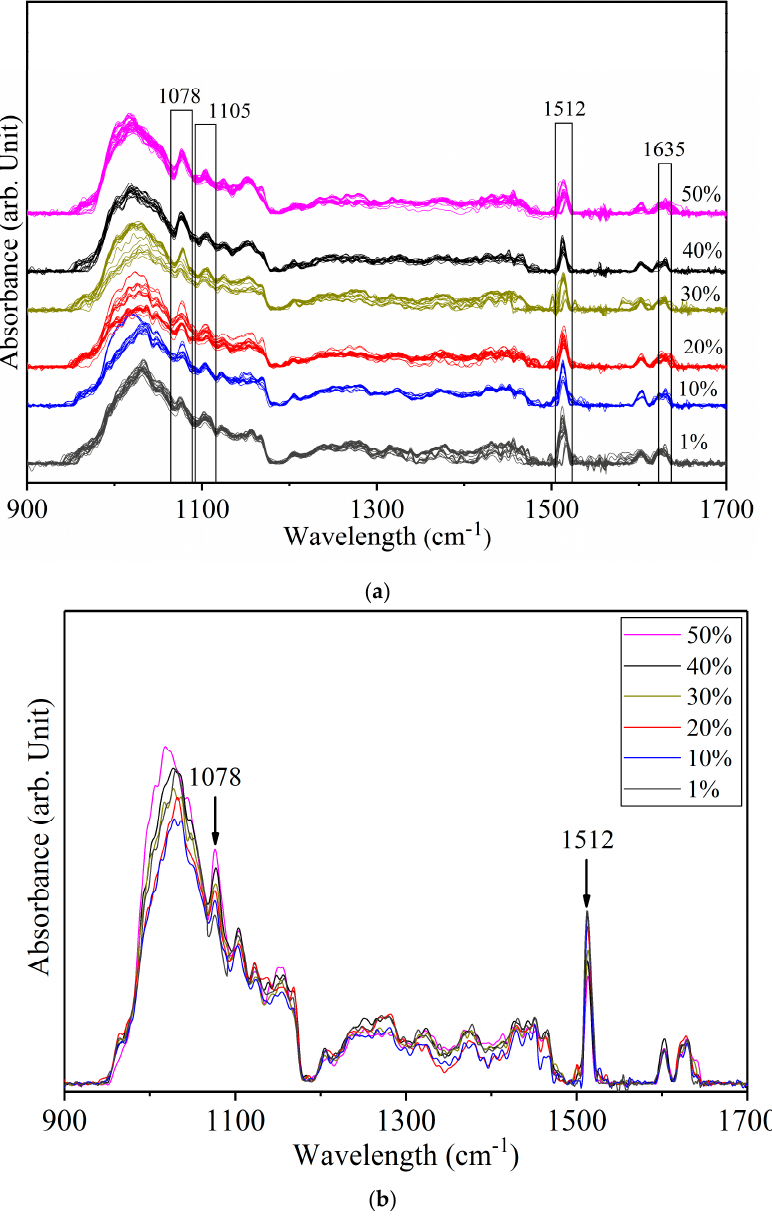
Figure 4. ( a ) Spectra of yellow turmeric—white turmeric samples at 1%, 10%, 20%, 30%, 40%, and 50% concentrations. ( b ) Average spectra of each concentration.